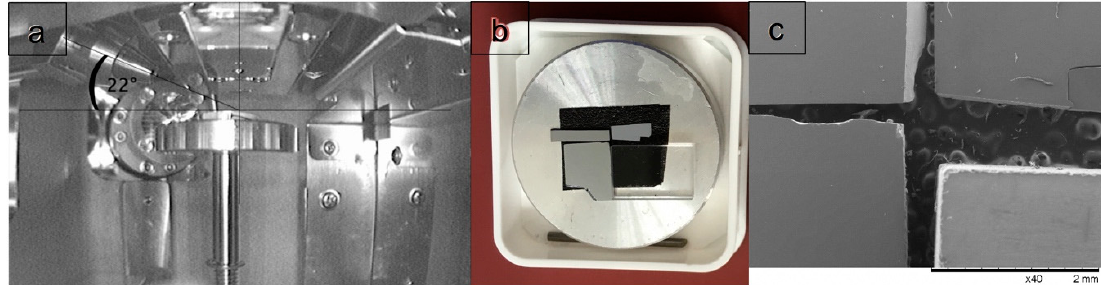
Figure 6. Side view showing SEM chamber with X-ray detector and take-off angle measurement ( a ), image of four specimens mounted on aluminium stub ( b ) and secondary electron image at 15 kV, 40 × magnification ( c ) in the Hitachi SEM 3030plus.